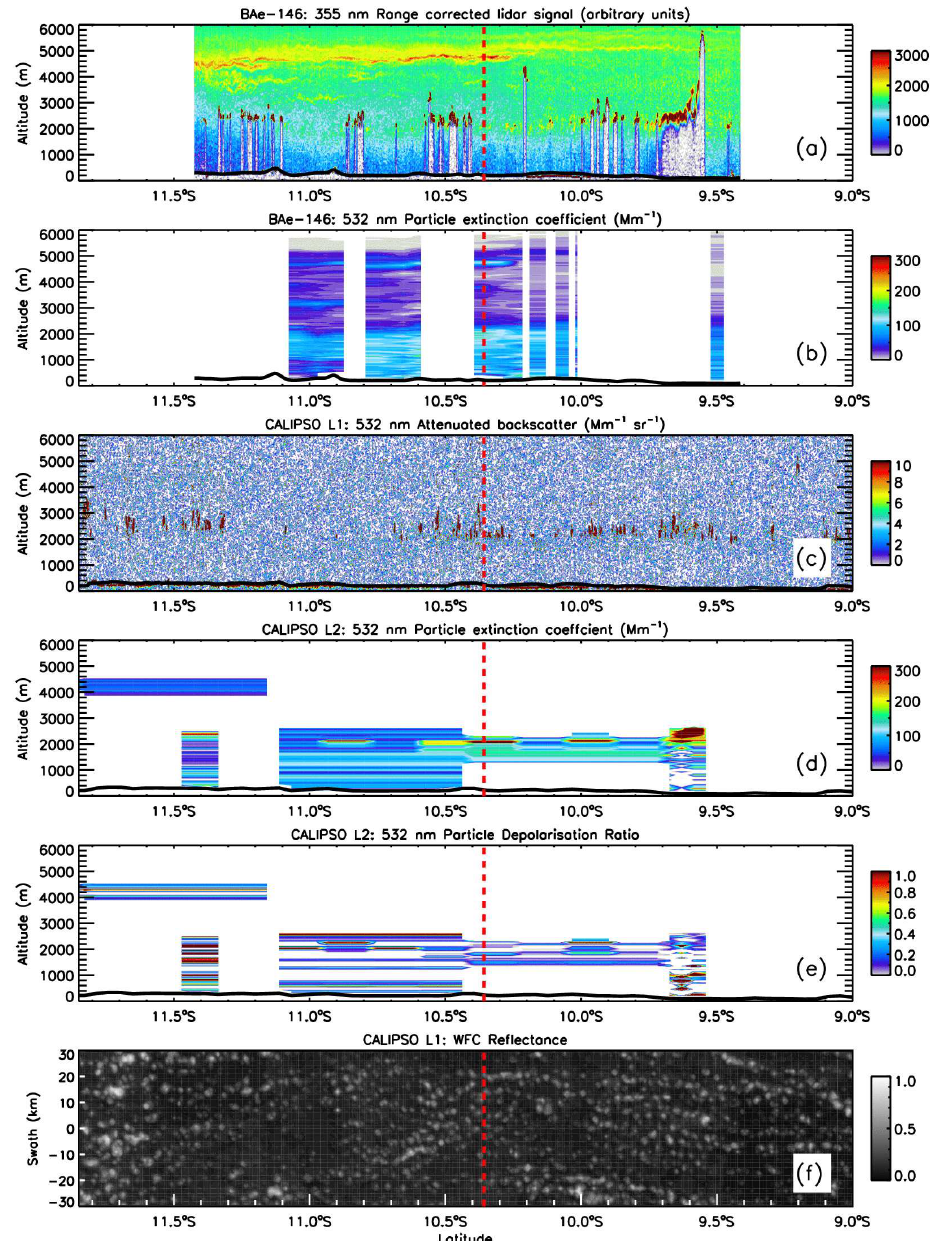
Figure 2. Latitude–height contour plots of quantities determined with the airborne and the spaceborne lidars: (a) Airborne lidar range corrected signal; (b) Airborne lidar extinction coefficient, converted to 532nm; (c) CALIPSO 532nm attenuated backscatter (Level 1 data); (d) CALIPSO 532nm extinction coefficient (Level 2 data); and (e) CALIPSO 532nm particle depolarisation ratio (Level 2 data). Panel (f) dis- plays the CALIPSO wide-field camera image in the 620–670nm wavelength band (Level 1 data, 1 × 1km native science data set). The dashed red vertical line indicates where the aircraft is flying closest to CALIPSO